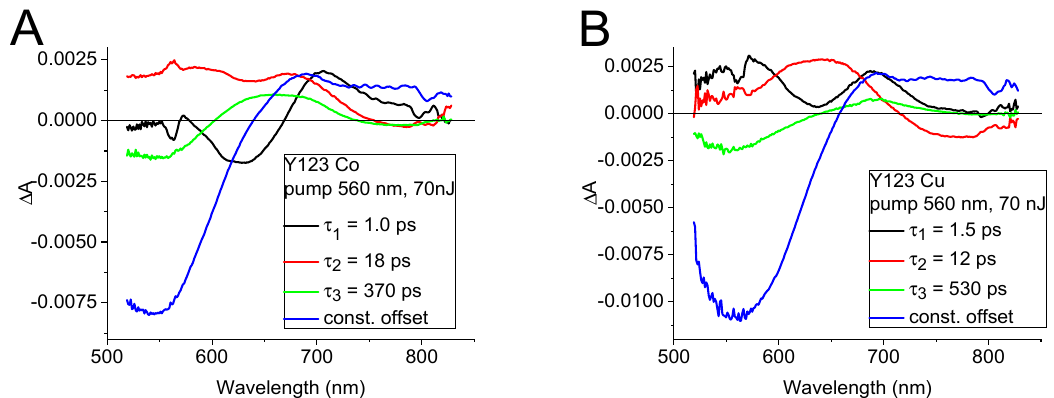
Figure 1. Pre-exponential factor spectra associated with the indicated time constants for a model with a three-exponential function with an offset for DSSC with Y123 dye and ( A ) cobalt- and ( B ) copper-based electrolyte for pump wavelength 560 nm.